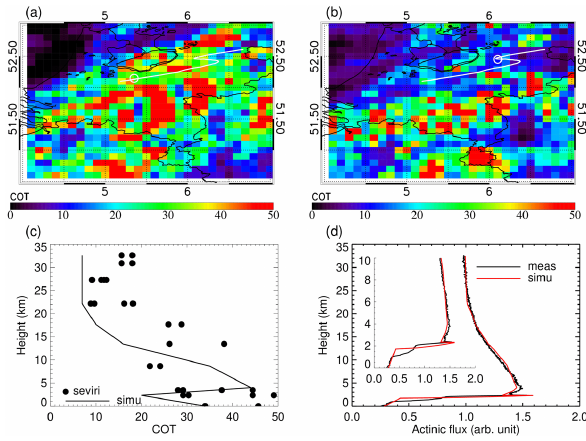
Figure 11. Same as Fig. 9 but for 22 June 2006.